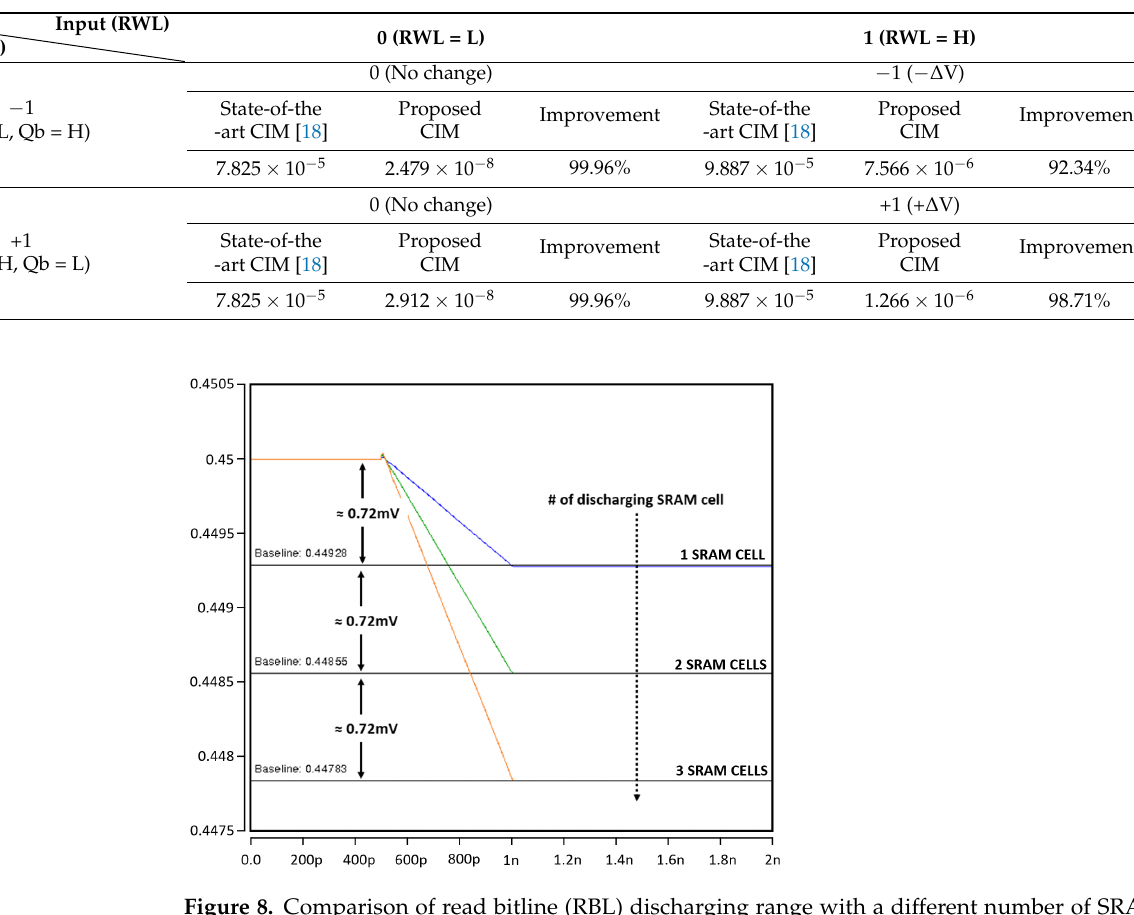
Table 3. Comparison of dynamic power consumption with state-of-the-art 8T SRAM-based CIM [18] for a possible four states with binary input/weight combinations.